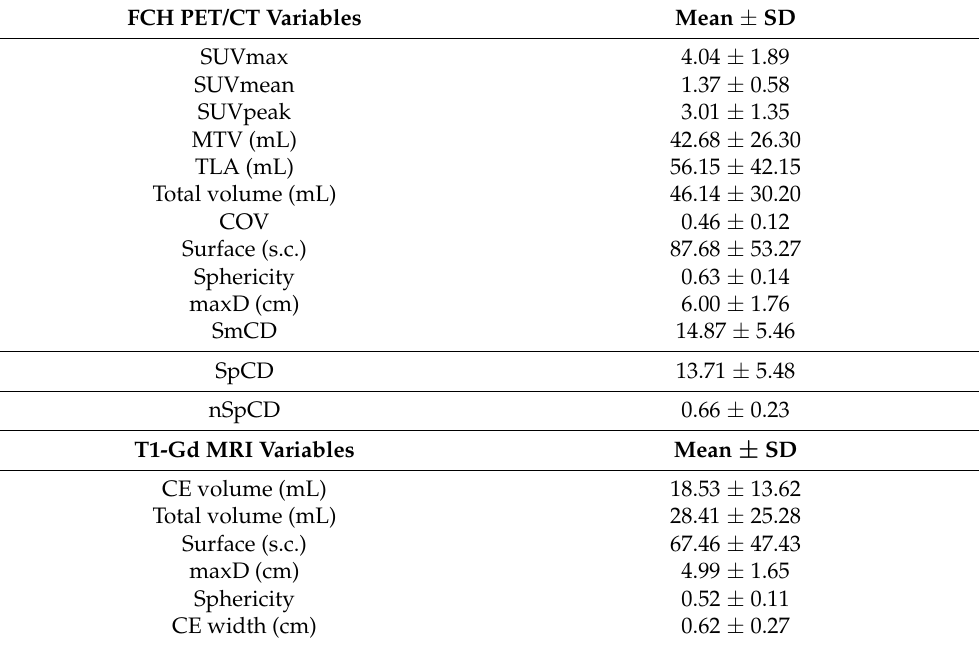
Table 2. Overall mean values of radiomics obtained on 18 F-fluorocholine PET/CT and T1-Gd